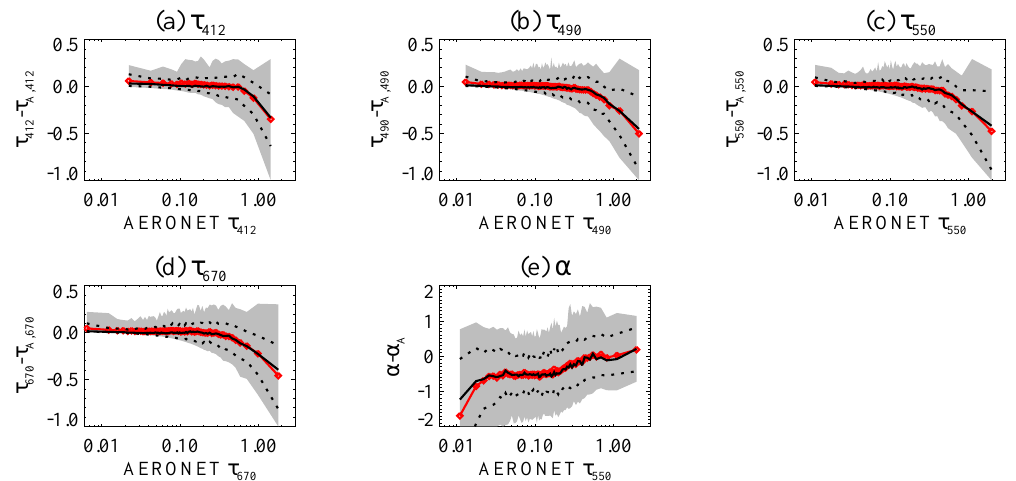
Fig. 4. Retrieval error (SeaWiFS-AERONET) as a function of AERONET AOD, for AOD at (a) 412nm, (b) 490nm, (c) 550nm, (d) 670nm; (e) ˚Angstr¨om exponent (as a function of AOD at 550nm). In these, data are binned in order of ascending AOD, with a bin size of 500 matchups. In each plot, the red line shows the mean error, the solid black line the median, dotted black lines the 16th and 84th per- centiles in that bin (i.e., the 68% confidence interval), and the shaded grey area the bounds of the 2.5th and 97.5th percentiles (i.e., the 95% confidence interval). Only points where QA=3 are included.